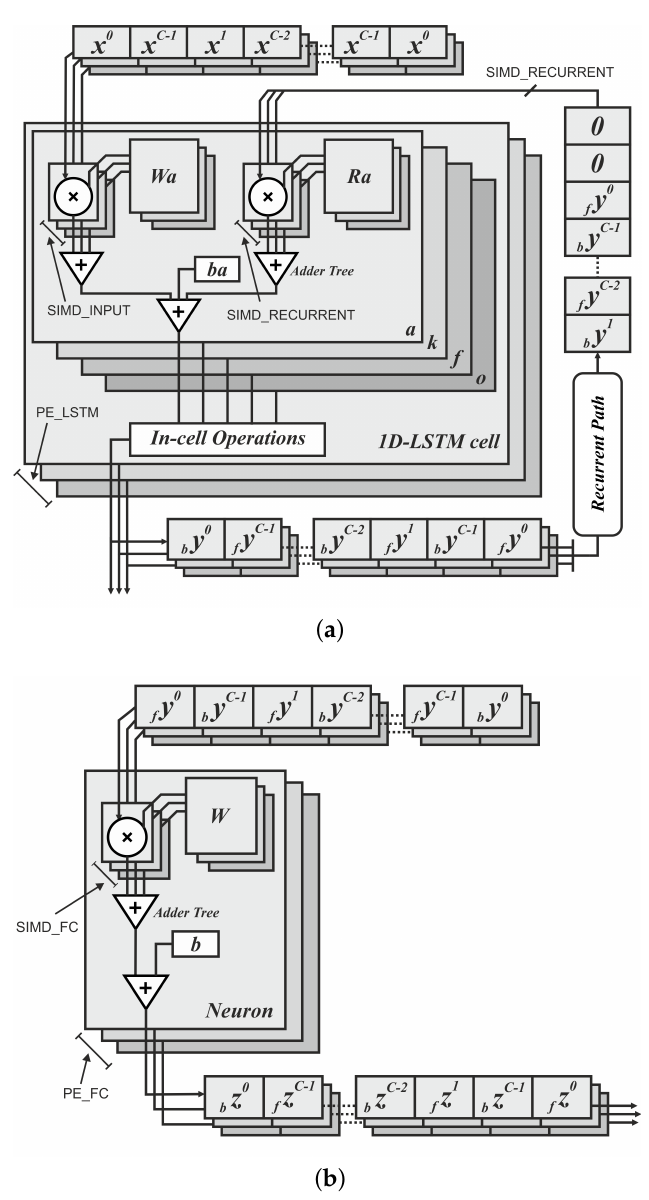
Figure 24. ( a ) Hardware design of the BiLSTM layer. ( b ) Hardware design of the Output Layer. The Output Layer module implements the dense layer folded with batch normalization; see Figure 24b, where f z t and b z t are output activations corresponding to the forward and backward processing directions. W is a weight matrix, and b is a bias corresponding to a neuron. Conventionally, the Output Layer processes the concatenated output sequences from the forward hidden layer and the backward hidden layer taken in reverse order. In this case, it requires waiting for 2 × N H × C clock cycles before all outputs from the